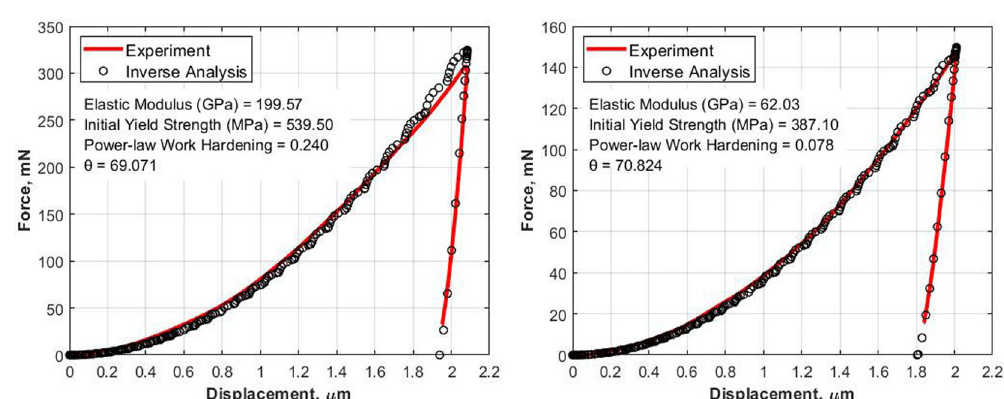
Figure 7. Force-Displacement data comparison between experiment and inverse analysis steel(left) and